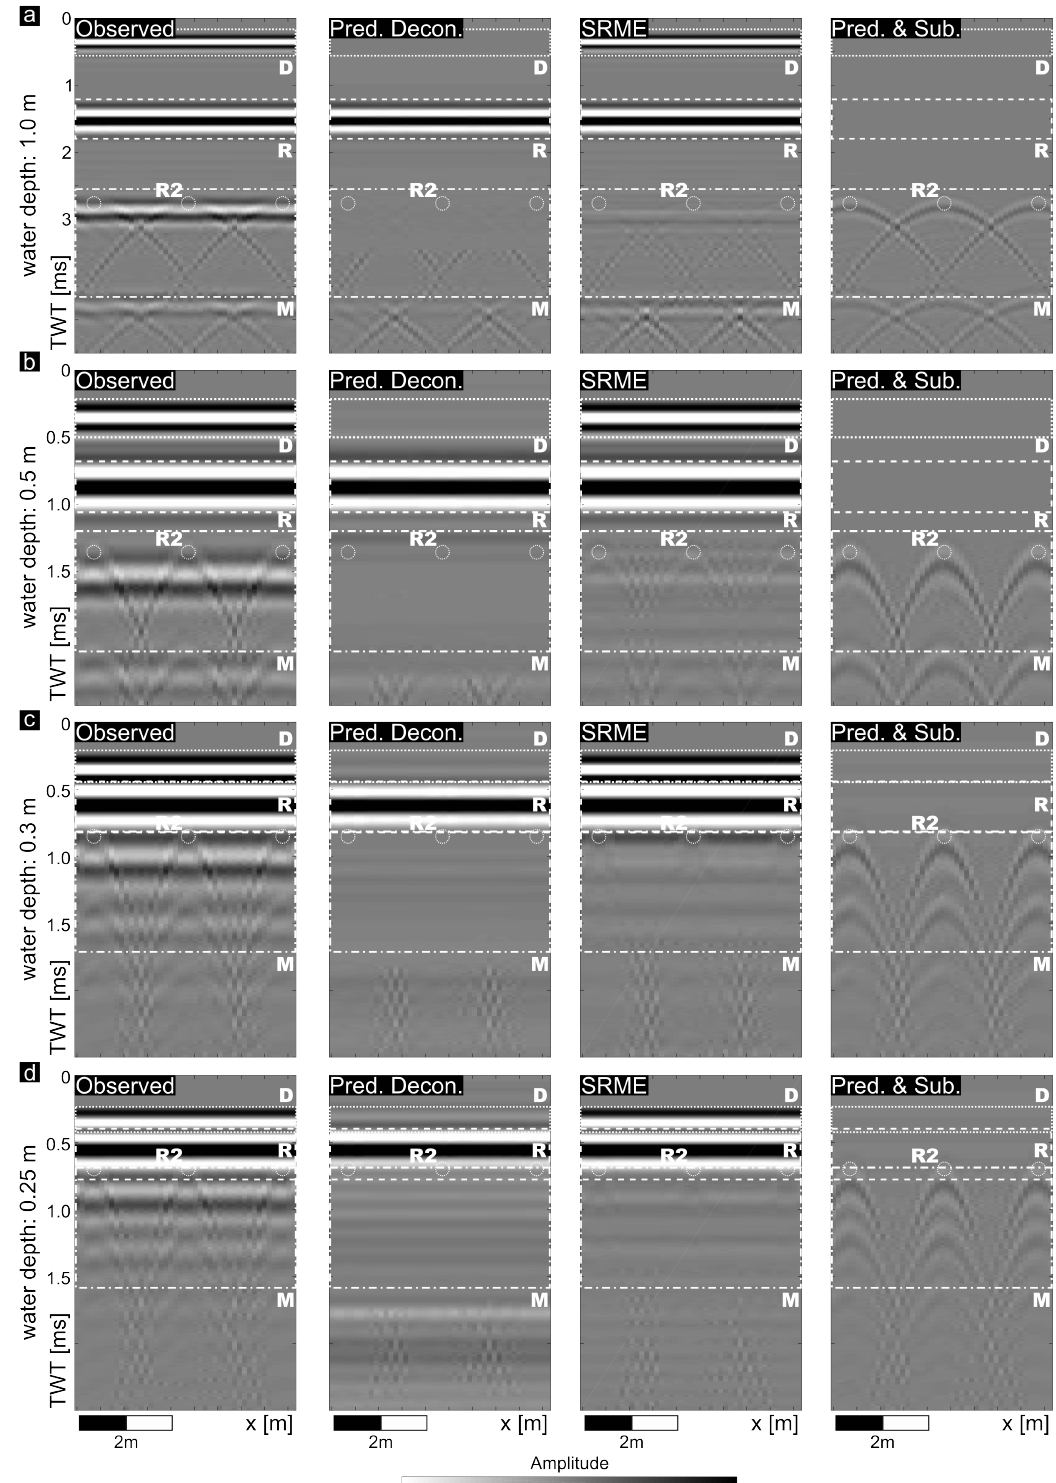
Figure 4. Results of multiple attenuation for a synthetic constant-offset section for water depth of 1.0m ( a ), 0.5m ( b ), 0.3m ( c ), and 0.25m ( d ). The direct wave (D), the water bottom reflection (R), and the water-layer multiple (M) are marked by white boxes. The positions of the scattering objects are marked by white circles (R2). The results of each applied attenuation approach as well as the original synthetic data are shown for each water